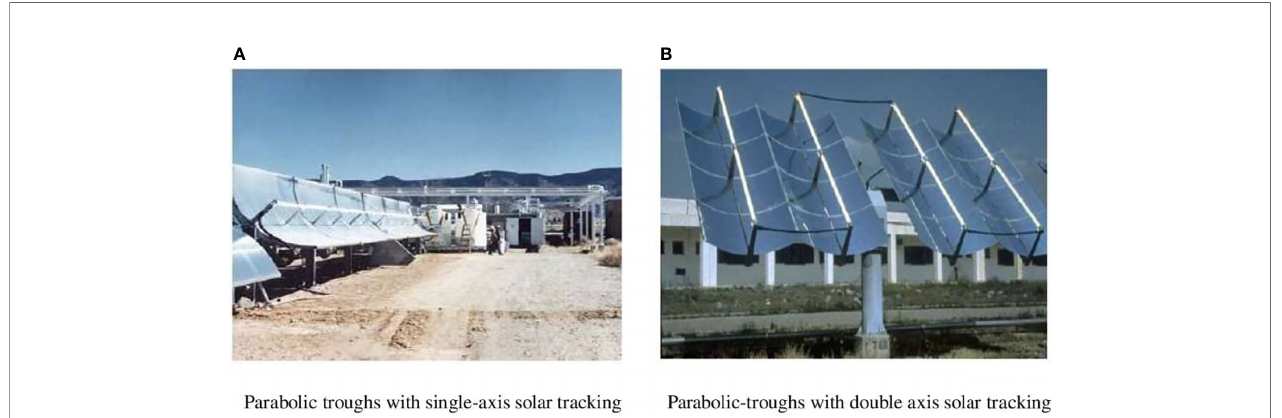
FIGURE 7 | Parabolic troughs reactor types with (A) single and (B) double axis solar tracking. Reproduced with permission (Malato et al.,